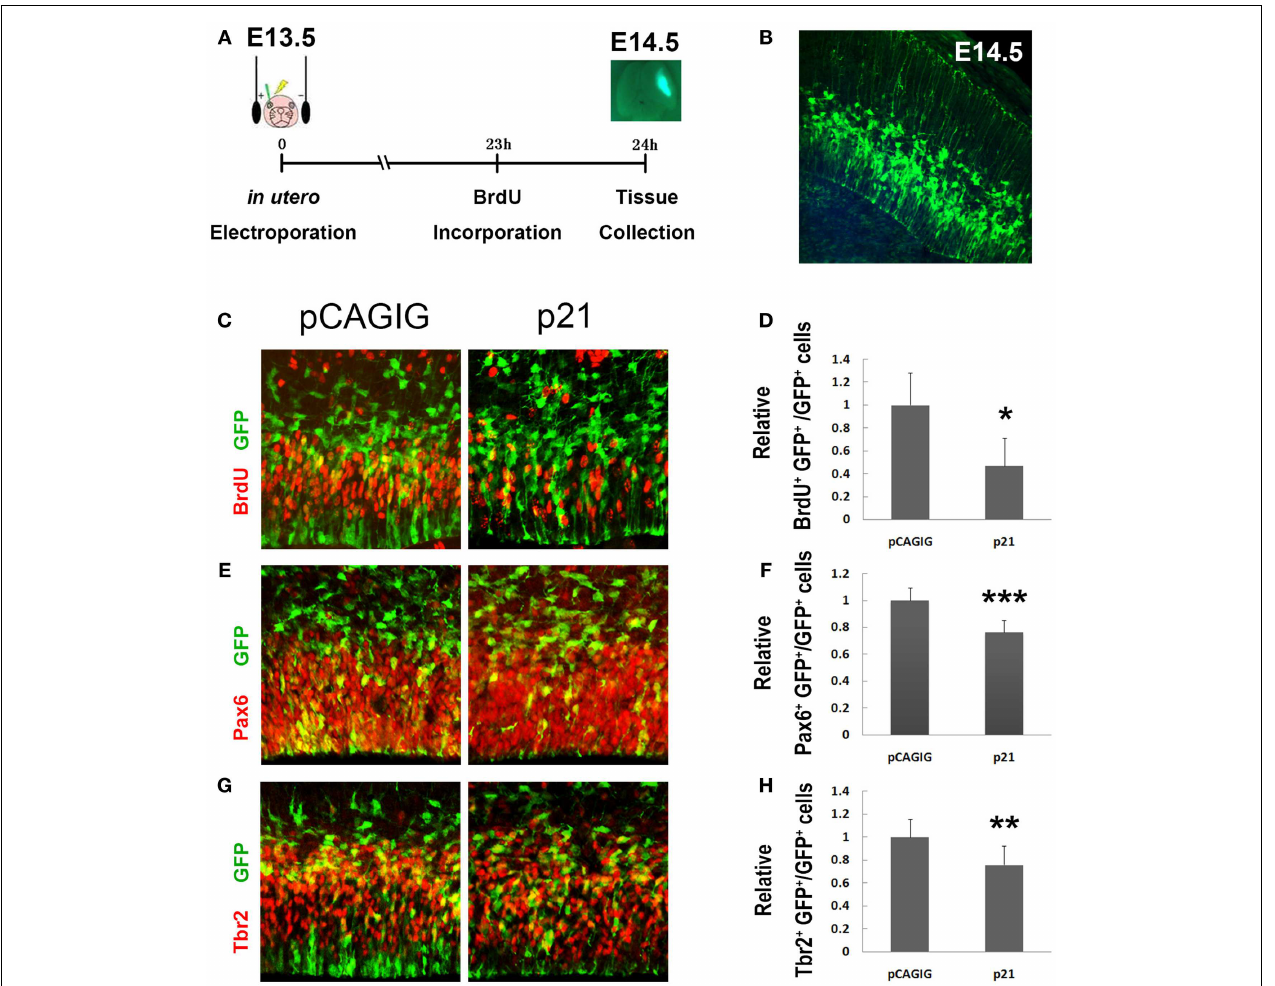
proliferating cells co-labeled with GFP and BrdU compared with the empty vector pCAGIG ( n = 4). (E,F) Overexpressing p21 ( n = 6) decreased the number of radial glial cells (RGCs) co-labeled with GFP and Pax6 compared with the empty vector pCAGIG ( n = 4). (G,H) Overexpressing p21 ( n = 5) decreased the number of intermediate progenitors (IPs) co-labeled with GFP andTbr2 compared with the empty vector pCAGIG ( n = 4). Data are presented as mean ± SEM; n ≥ 3 in all constructs; p values in relation to the control (* p < 0.05, ** p < 0.01, *** p <